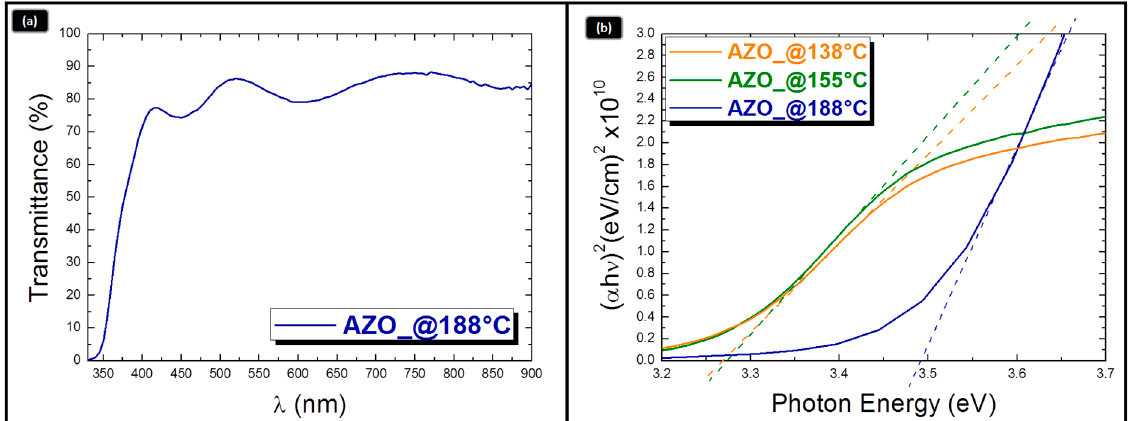
Figure 5. ( a ) Transmittance spectra of an AZO sample deposited at 188 °C; and ( b ) Tauc plots of AZO layers deposited at different temperatures to evaluate the optical band gap.